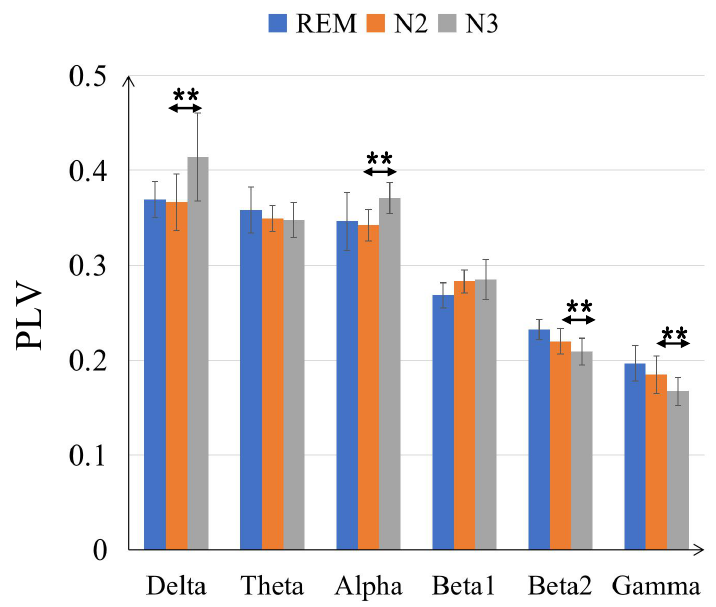
Figure 4. Comparisons of the average PLV values between six frequency bands for three sleep stages. The double-asterisk ‘**’ indicates that there is a significant difference of p < 0.001 by ANOVA test.